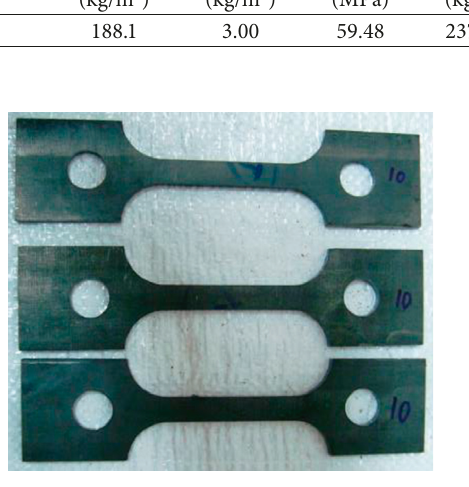
Figure 2: Steel coupon specimen. Table 3: Properties of steel tubes.